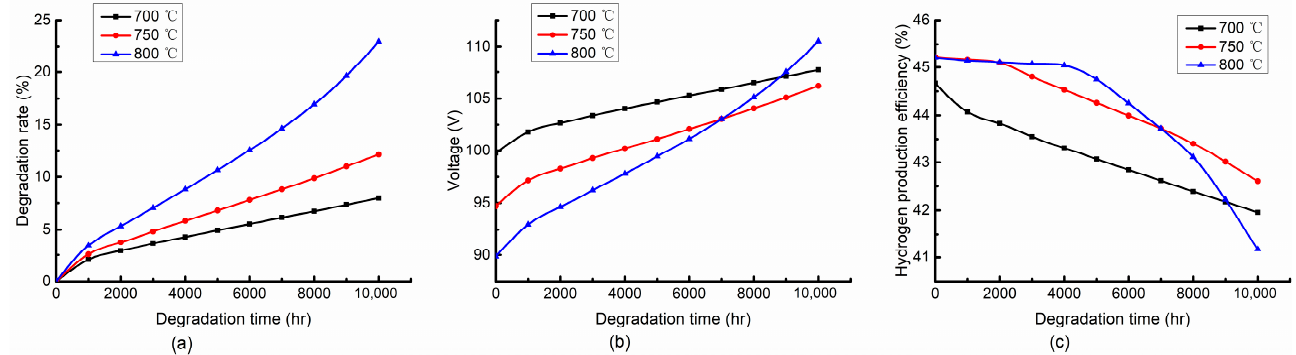
Figure 5. Variation trends of ( a ) degradation rate, ( b ) stack voltage and ( c ) hydrogen production efficiency with degradation time at 700 °C, 750 °C and 800 °C. (Operating at 5000 A/m 2 and air-to-fuel feed ratio of 3).